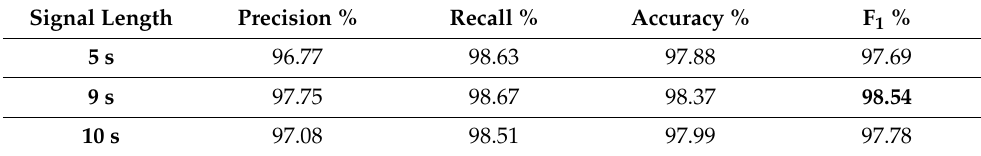
Table 12. Comparison of the results of our proposed model with different signal lengths.